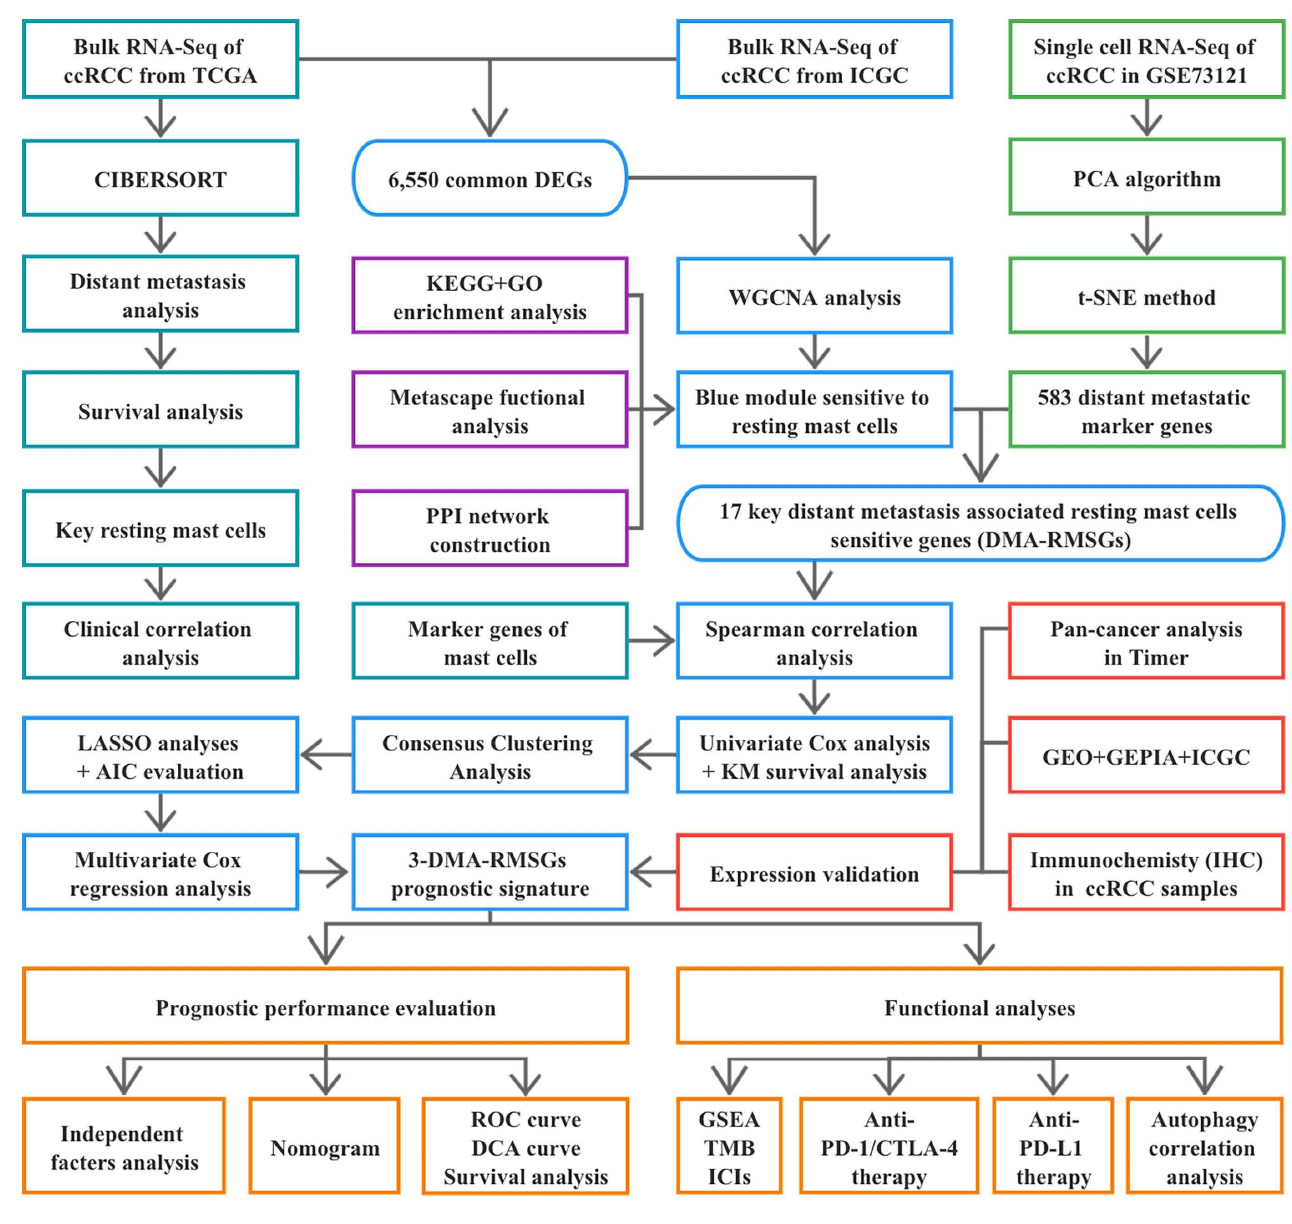
Figure 1. Workflow of the study. Turquoise rectangles represent the identification of key resting mast cells (RMCs). Green rectangles indicate screening of distant metastatic marker genes. Purple rectangles represent functional enrichment analysis of resting mast-cell-sensitive genes (RMSGs). Blue rectangles indicate the construction of the 3-DMA-RMSG prognostic panel. Red rectangles represent external validation of the 3-DMA-RMSG prognostic panel. Orange rectangles exhibit the predictive value and biological function of the 3-DMA-MRSG panel.